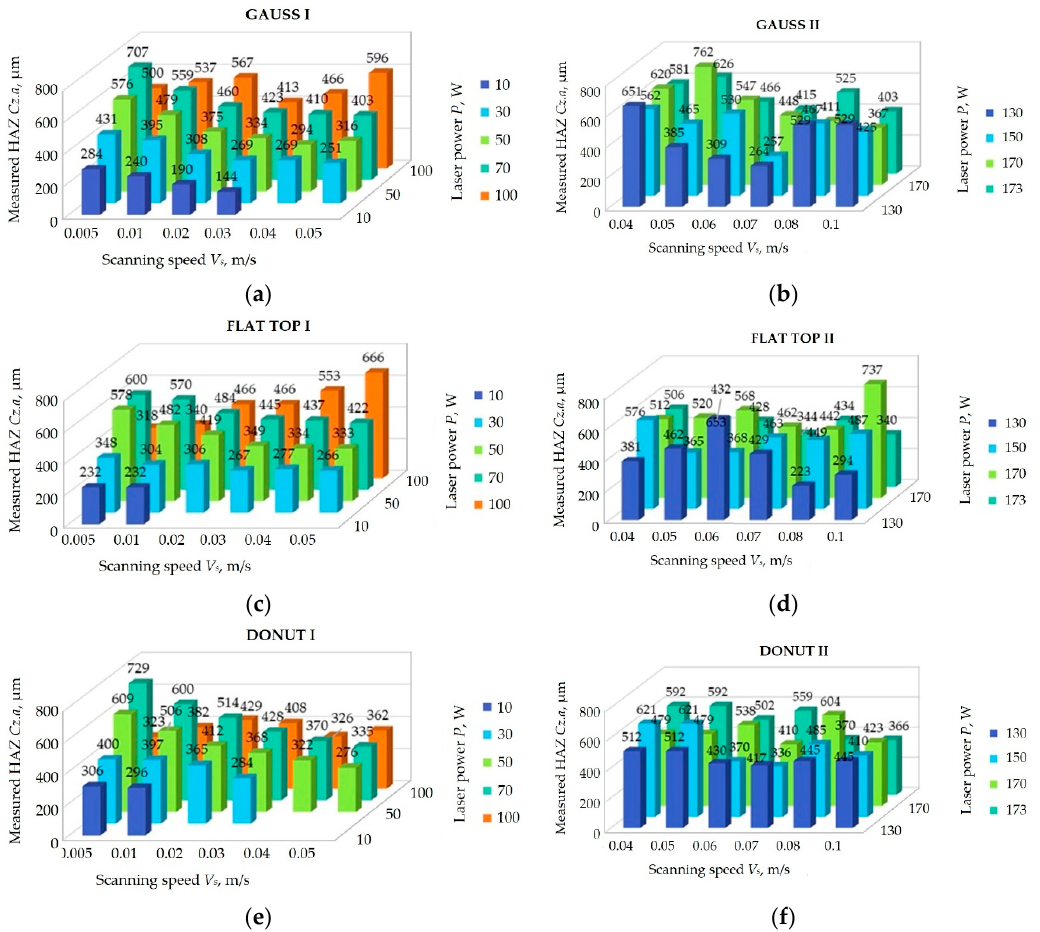
Figure 11. Dependence of heat-affected zone width of single tracks on process parameters for CoCrMo powder: ( a ) for technological gap I of Gauss; ( b ) for technological gap II of Gauss; ( c ) for technological gap I of flat top; ( d ) for technological gap II of flat top; ( e ) for technological gap I of donut; ( f ) for technological gap II of